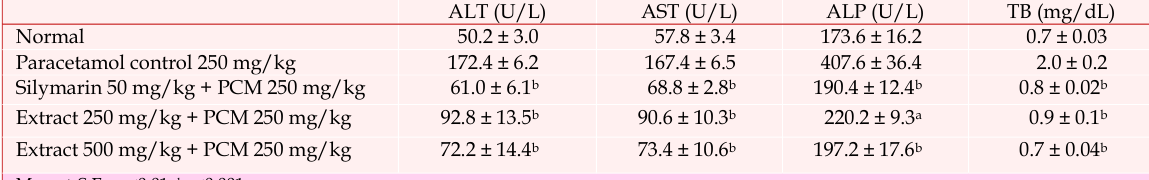
total bilirubin